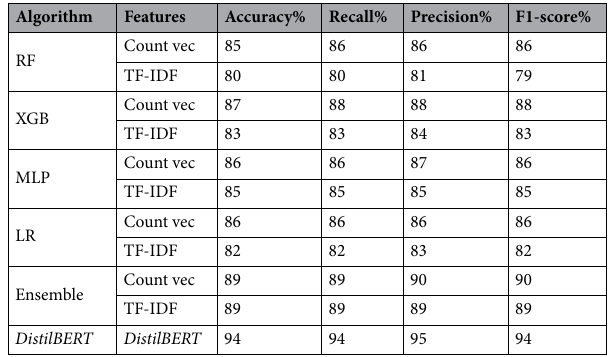
Table 4. All Feature Extraction and algorithm Results for Article2 Dataset with 10 Authors.